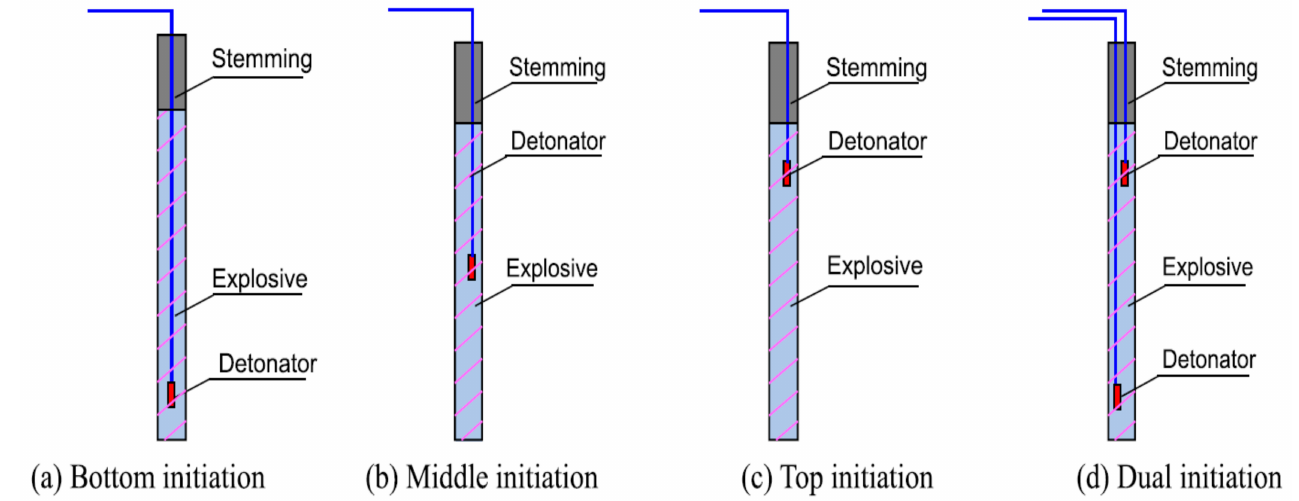
Figure 4. Schematic of different positions of initiation point